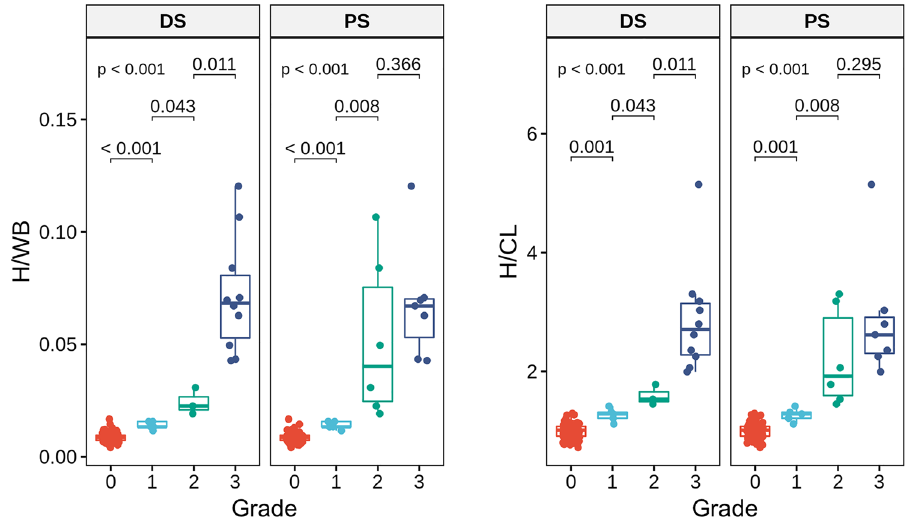
Figure 1. Planar image indexes according to the visual grades. H/WB and H/CL were significantly different between grades 0/1 and 1/2 for both DS and PS. However, H/WB and H/CL were significantly different between grades 2/3 only for DS, but not for